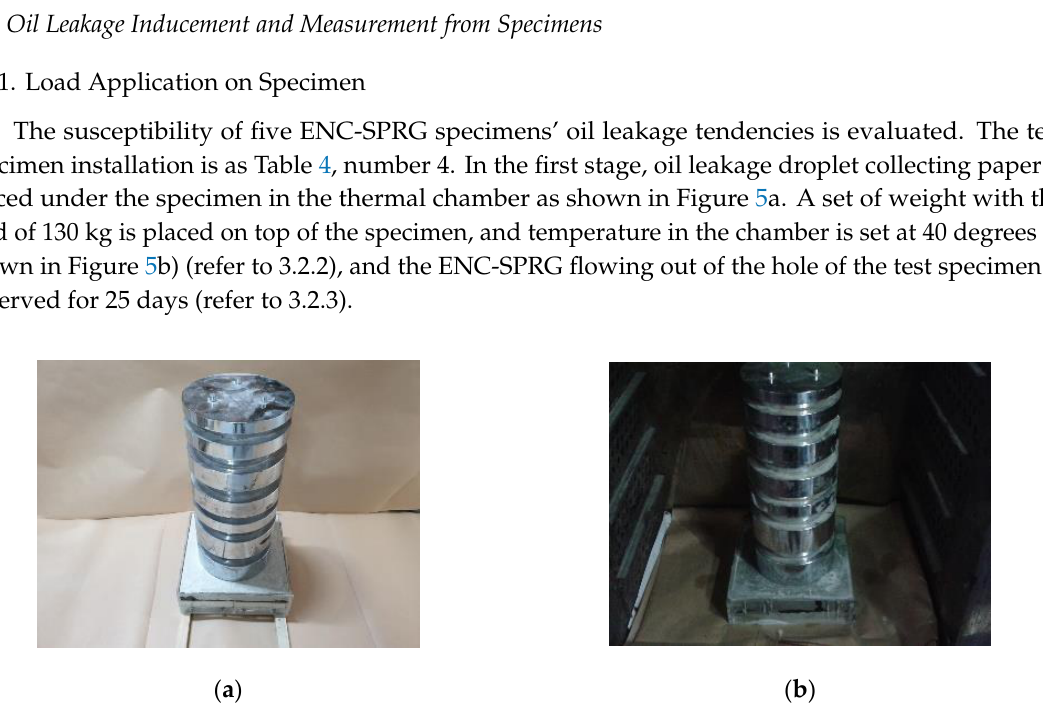
Figure 5. Load conditioning on specimen, ( a ) pressure load applied, ( b ) set in a temperature chamber.